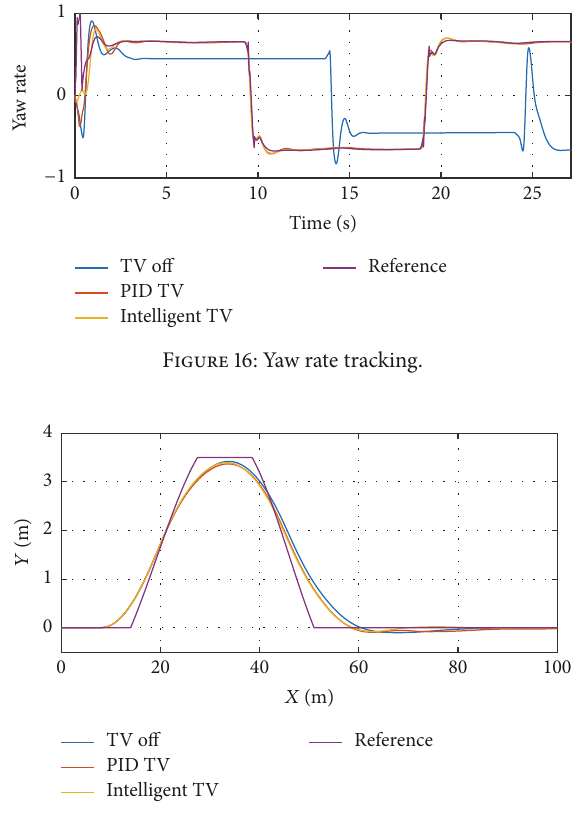
Figure 17: Double lane change trajectory.